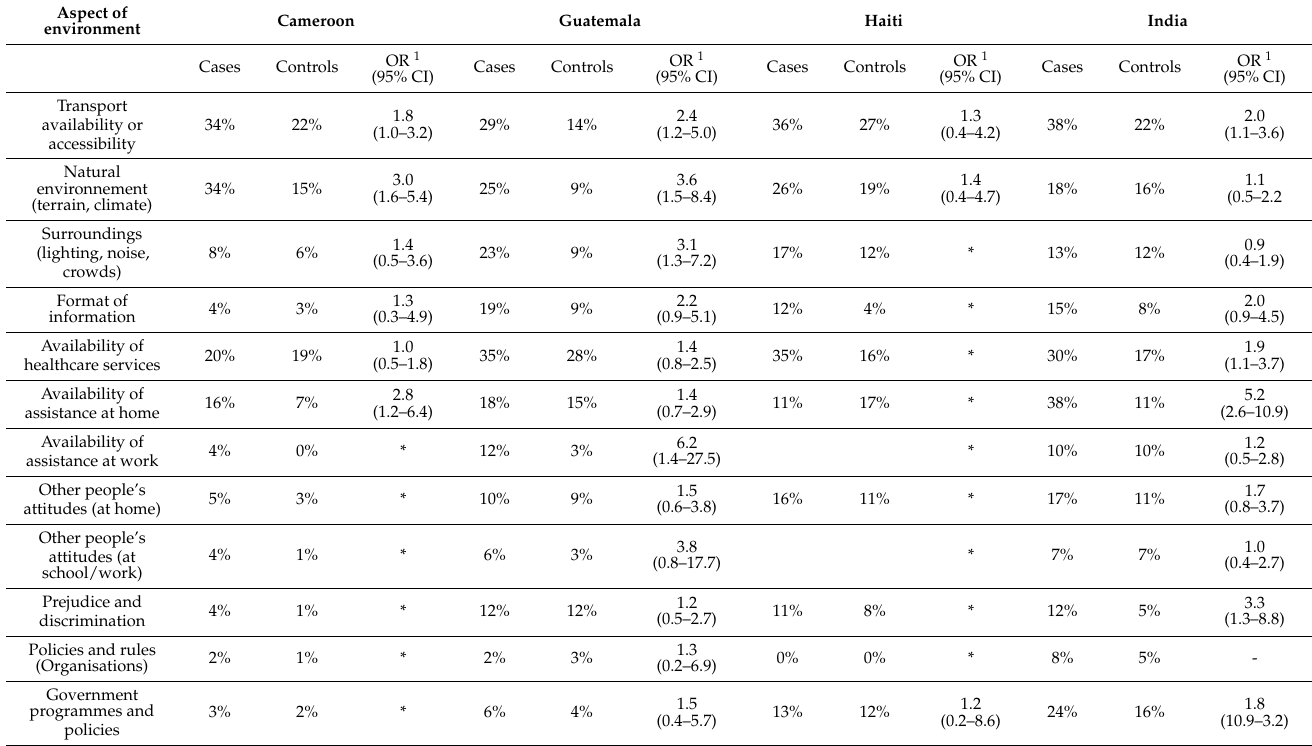
Table 4. Proportion of older adults with and without disabilities reporting that different aspects of the environment were a ‘big problem’ in terms of creating a barrier to participation in activities that matter to them. Aspect of environment